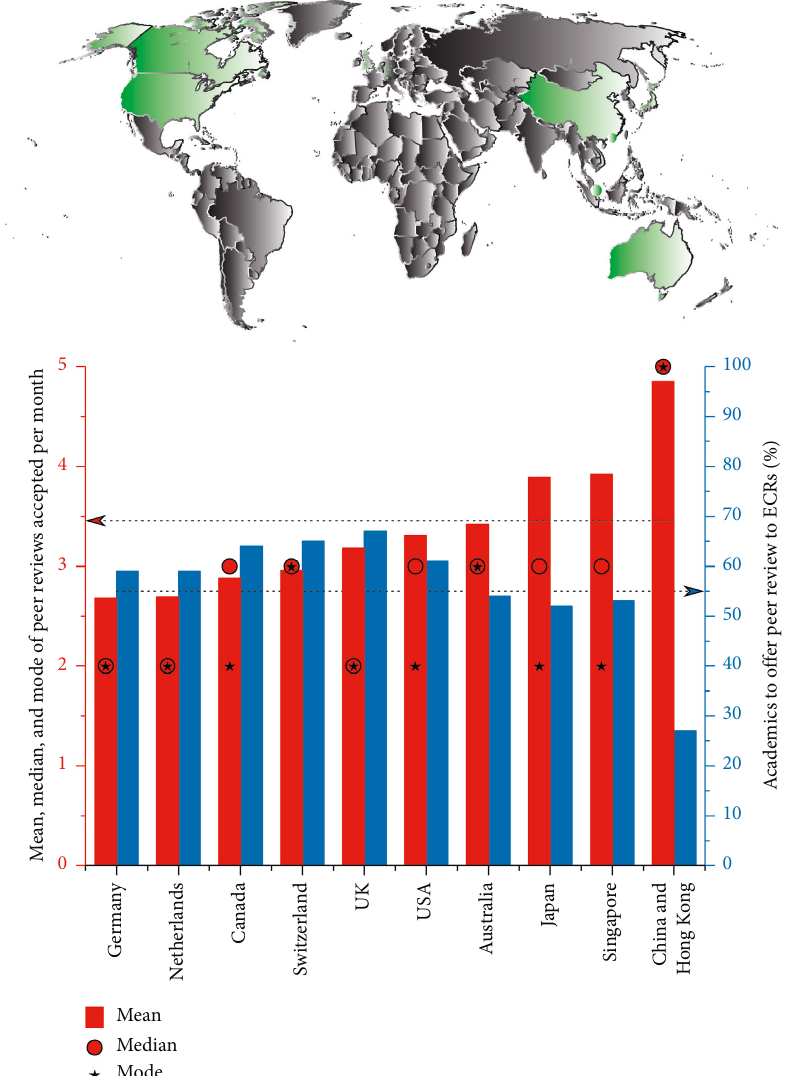
Figure 3: Mean, median, and mode of peer reviews accepted per month by academics (left axis (red)) and percentage of academics who offered peer review opportunities to ECRs (right axis (blue)) for all countries represented in the survey. The total average of monthly accepted peer reviews and the overall percentage of peer review offering academics are indicated by the dotted